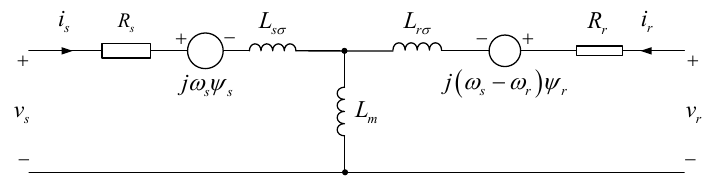
Figure 2. Equivalent circuit of an induction machine for transient